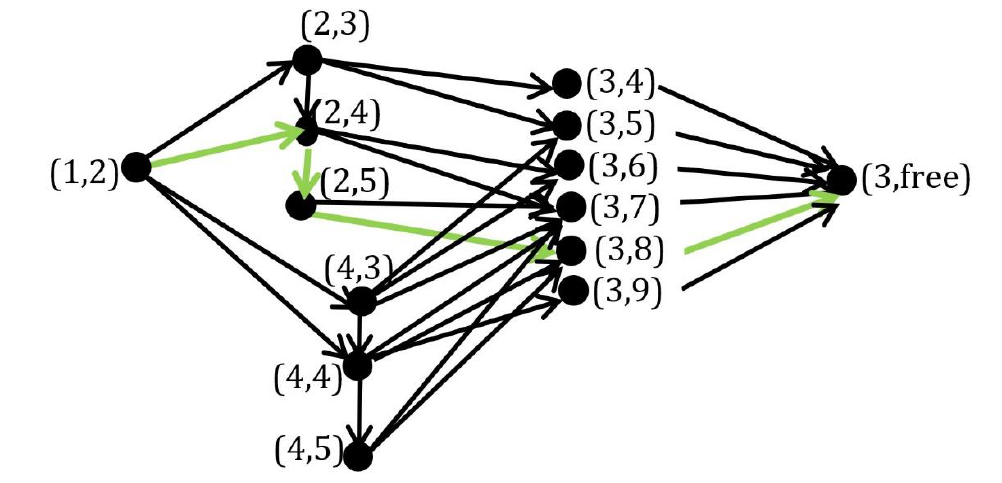
Figure 7. ESTEN representation for four-node network (with stops), with minimum feasible fuel consumption space-time route highlighted